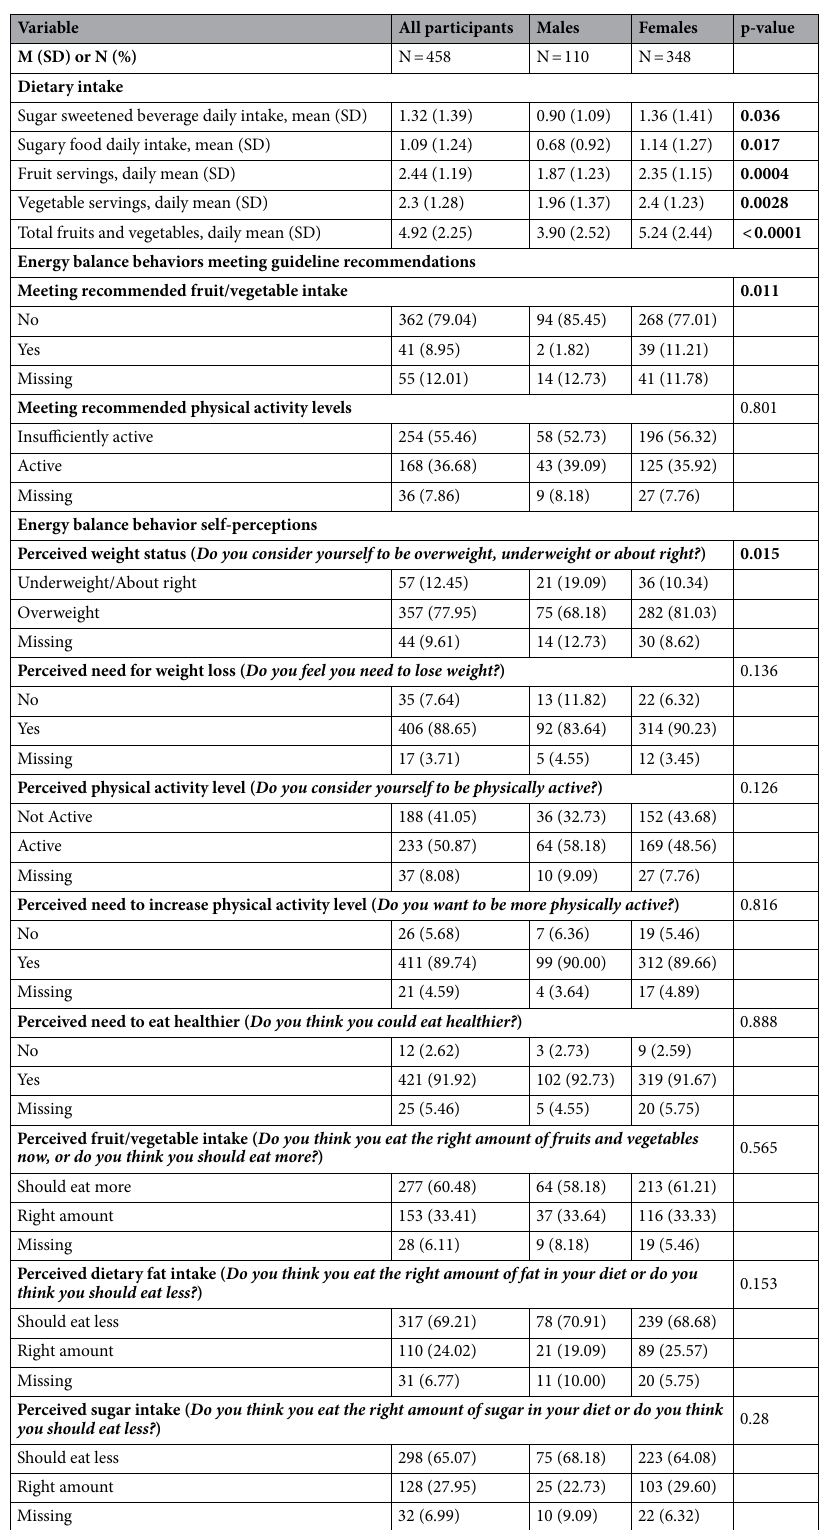
Table 2. Behavioral characteristics and perceptions at baseline. M mean, SD standard